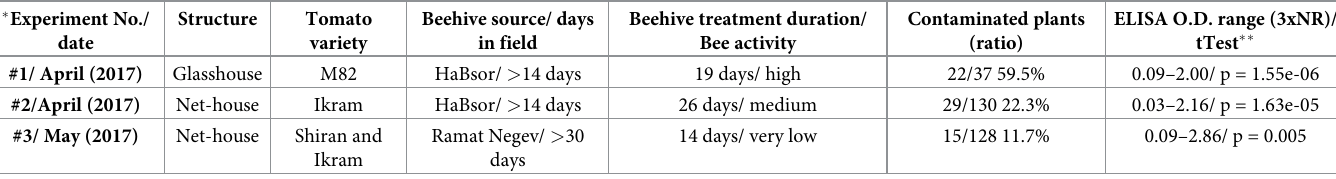
Table 1. ToBRFV contaminated bumblebee hives carry a primary inoculum that infects tomato